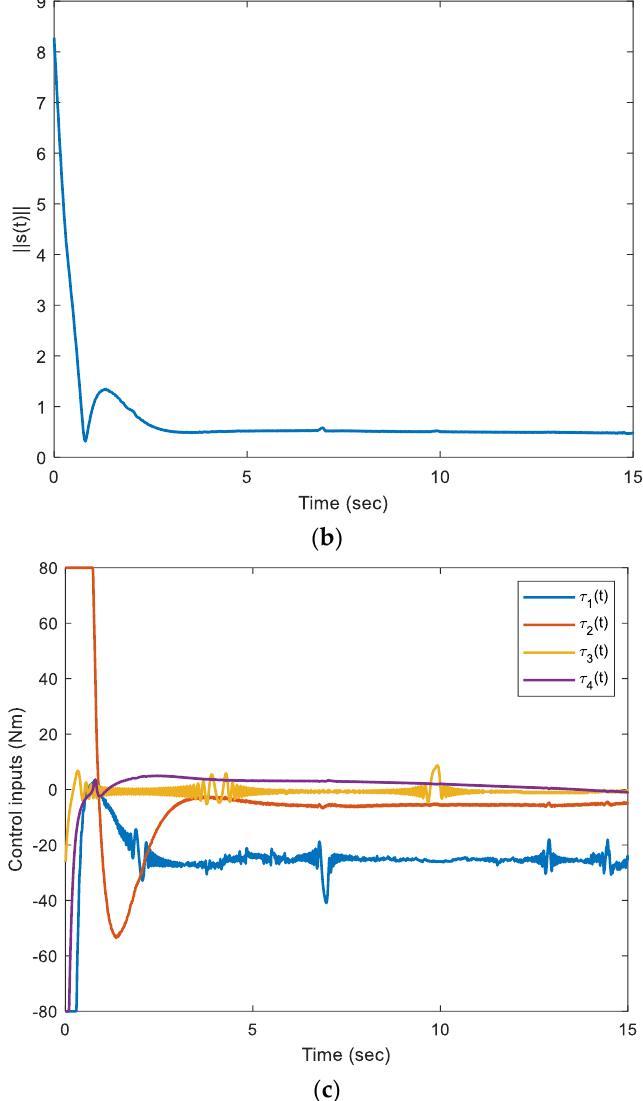
Figure 3. Responses of the AUV system in the presence of external current disturbance and input saturations with known parameters reflecting a regression matrix. ( a ) Trajectory − tracking. ( b ) Norm of nonlinear auxiliary sliding surfaces. ( c ) Control inputs.